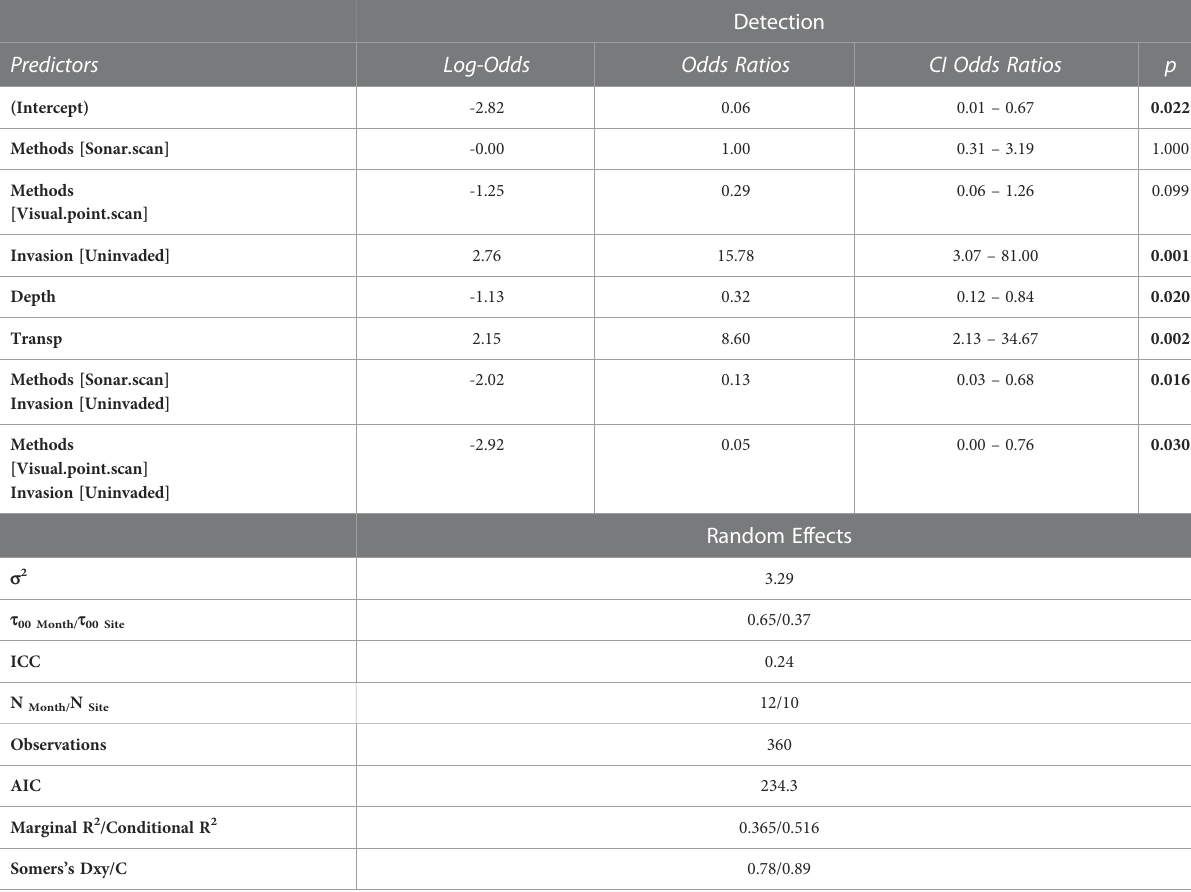
TABLE 3 Output of the binary logistic regression predicting African manatee detection in Lake Ossa as a function of water depth and transparency and an interaction between the survey methods and Giant Salvinia